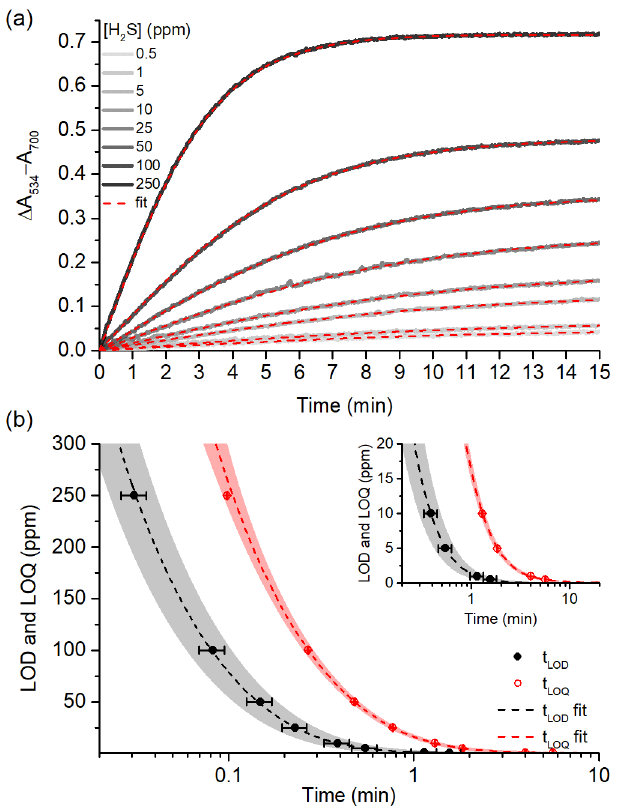
Figure 4. ( a ) Kinetics for the colorimetric signal S ( t ) (see text for details) of the sensor as a function of the H 2 S concentration in the passive sampling experiment. Grayscale lines indicate the experimen- tal data, while red dashed lines correspond to the sigmoidal fits described in the text (see Equation (1)). ( b ) Semilog plots of the experimental LOD ( S/N = 3) and LOQ ( S/N = 10) values for different exposure times (symbols). Dashed lines correspond to the analytical inversion of Equation (1). Shaded regions correspond to the error limits obtained from the fitting function, and the error bars stand for the experimental error ( ± 1 σ ) of triplicate experiments. Inset shows the low concentration